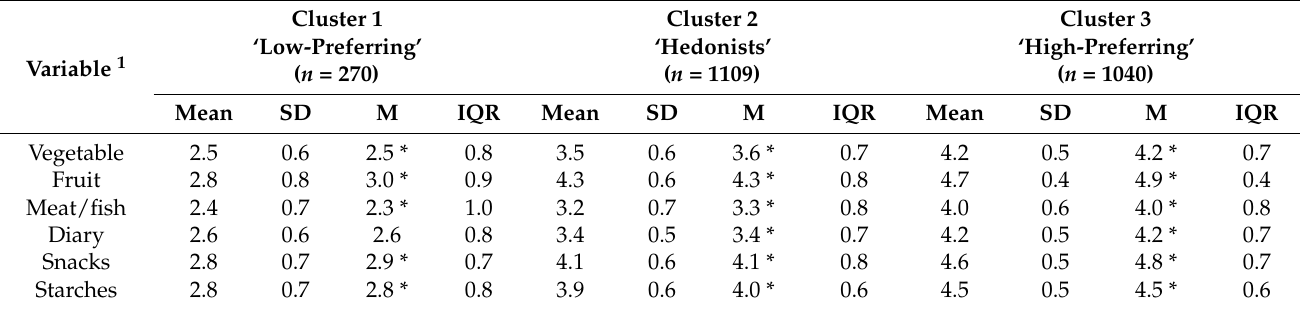
Table 1. The food preferences assessed while using the Food Preference Questionnaire (FPQ) within the population of the second phase of the Polish Adolescents’ COVID-19 Experience (PLACE-19) Study ( n = 2419).